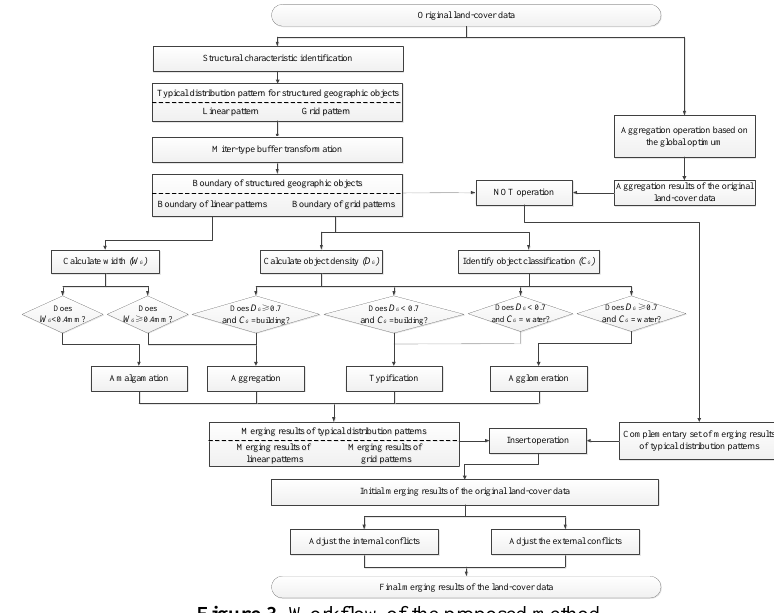
Figure 3. Workflow of the proposed